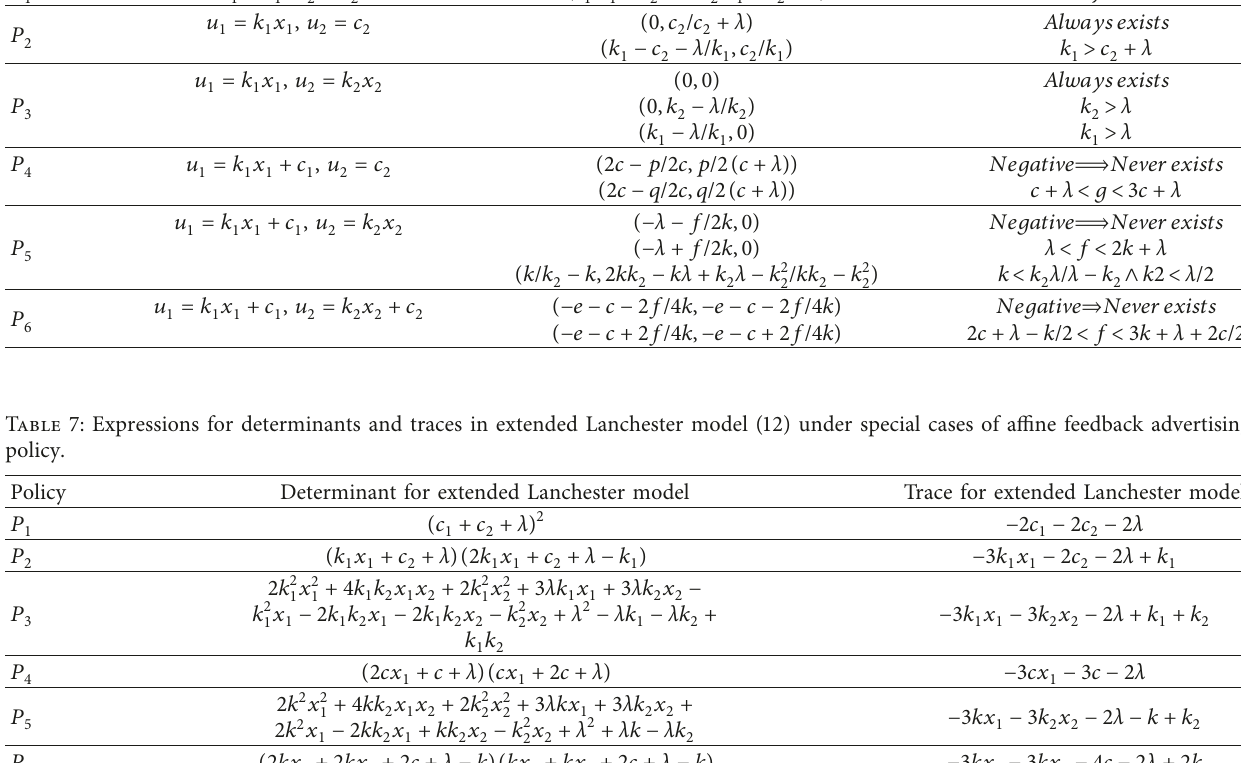
and x under affine feedback advertising policies P 1 2